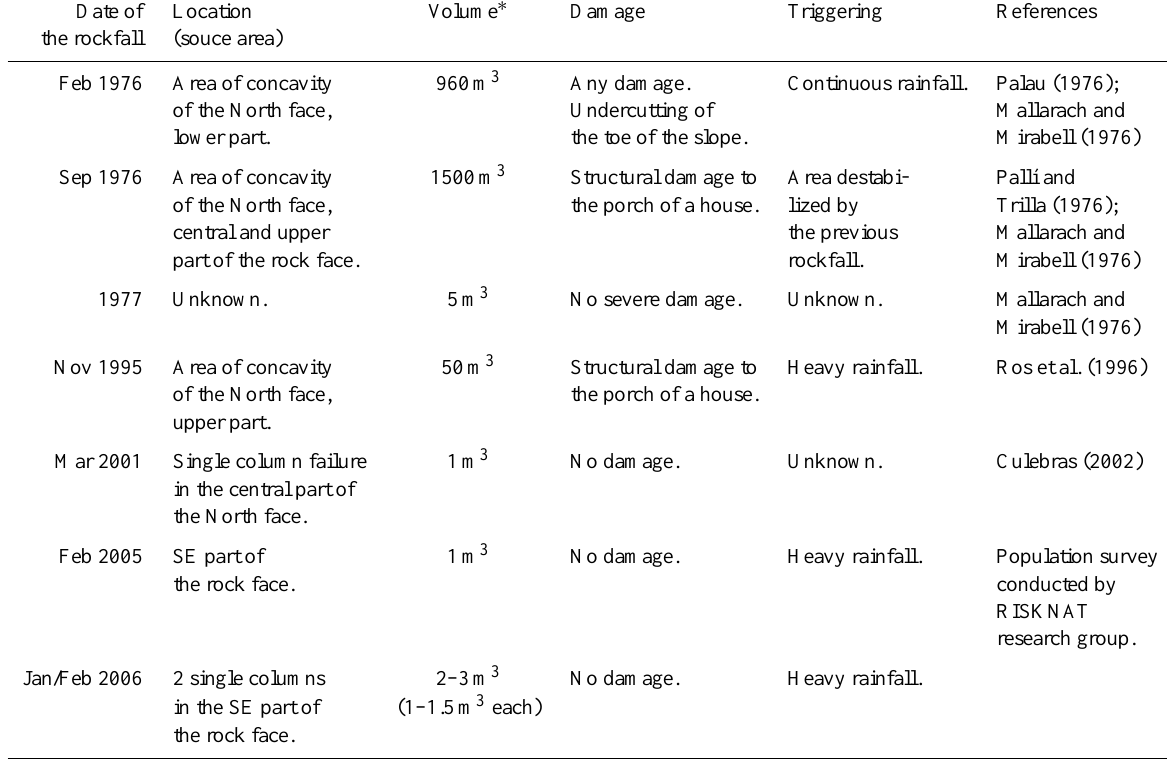
Table 2. Historical record of rockfalls in the 30 years prior to our study. Modified from Asensio et al. (2010).